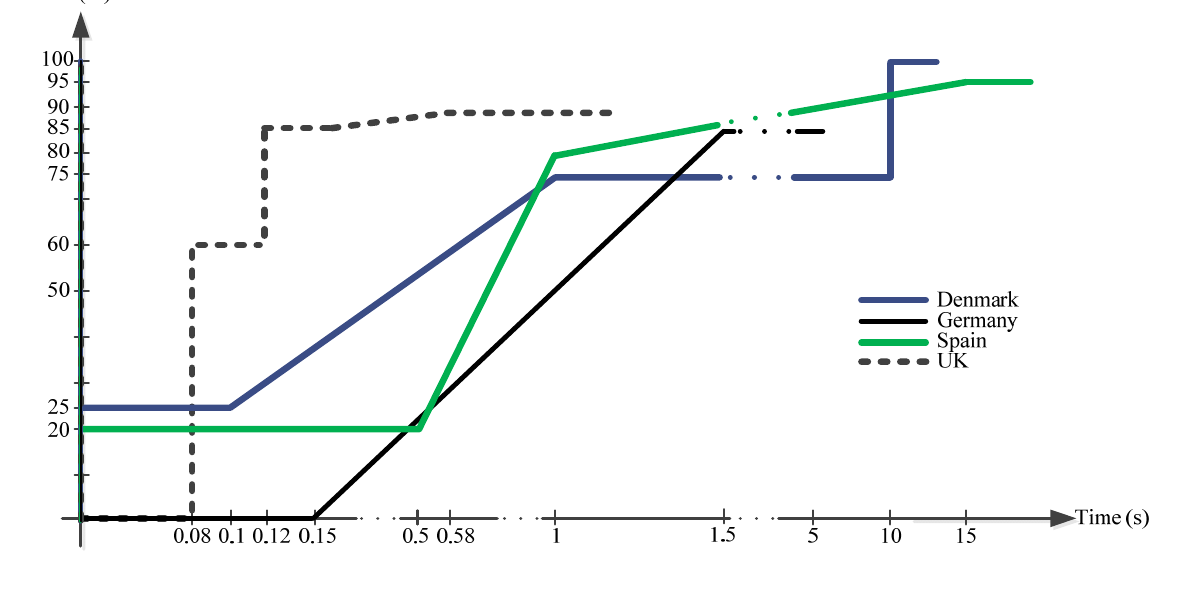
Table 2. Technical characteristics of the LVRT